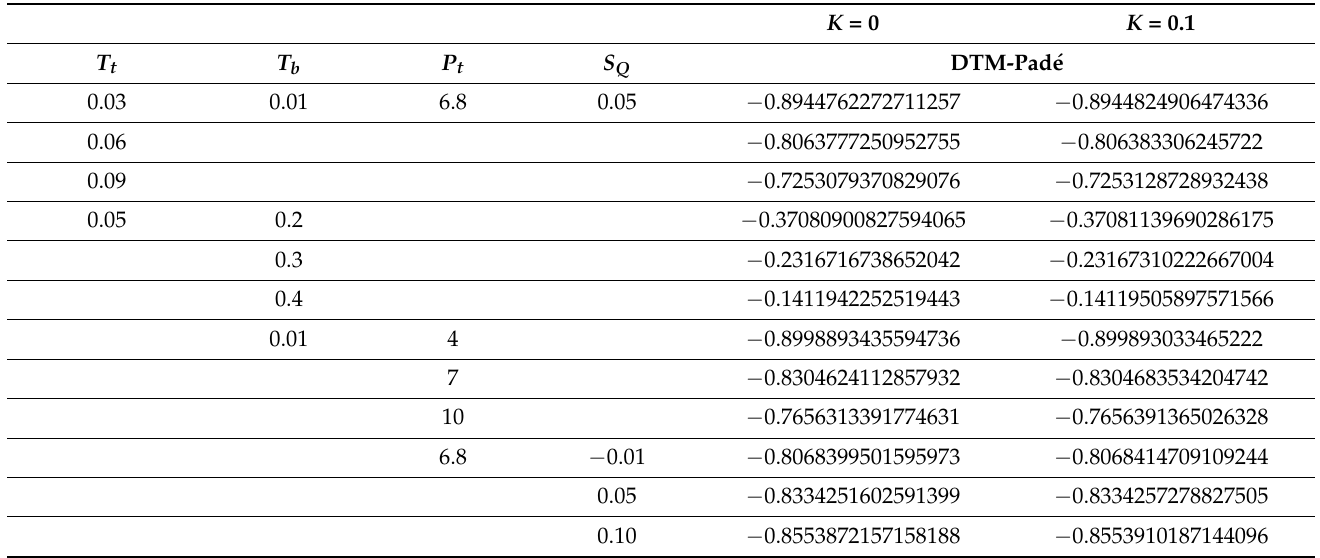
Table 2. Analysis of Nusselt number θ (cid:48) ( 0 ) , for multiple values T t , T b , P t , S Q by DTM-Pad é [ 5 × 5 ] .